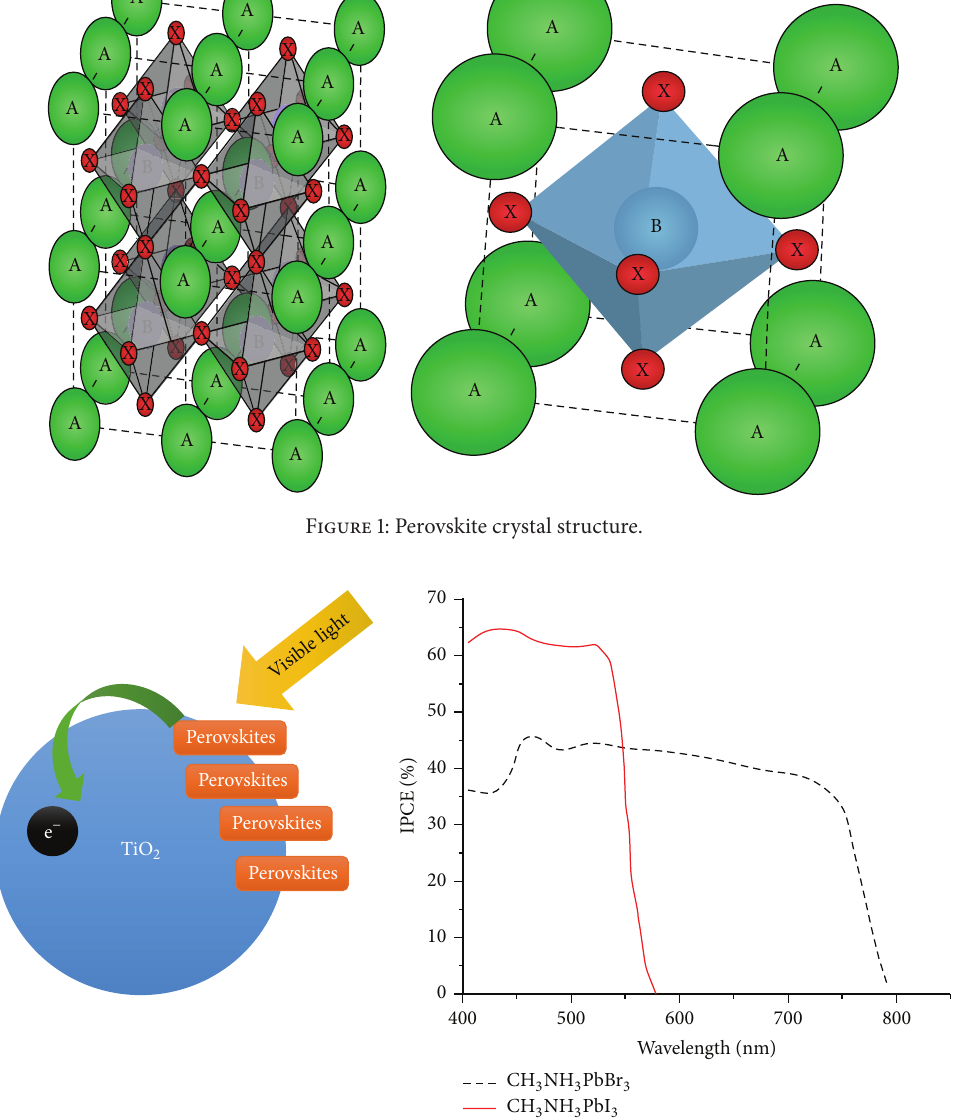
Figure 2: Schematic of perovskite-sensitized TiO 2 undergoing photoexcitation and electron transfer (left). The incident photon-to-electron conversion efficiency (IPCE) spectra for perovskite-sensitized solar cells